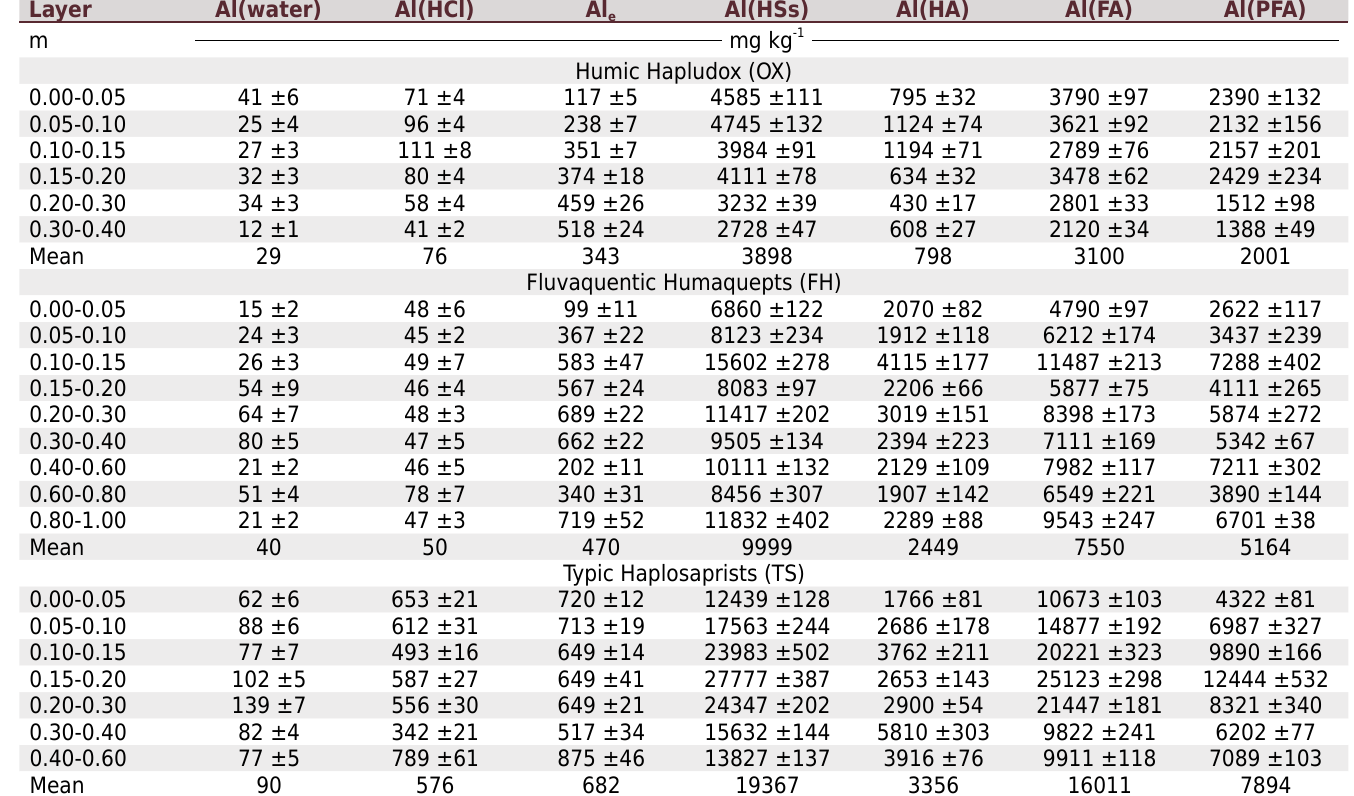
Table 5. Aluminum in water extract [Al (water) ], Al in HCl extract [Al (HCl) ], exchangeable Al 3+ (Al e ), Al in NaOH extract [Al (HSs) ], Al associated with HA [Al (HA) ], Al in FA extract [Al (FA) ], and Al in FA extract after purification with DAX-8 resin [Al (PFA) ] contents of soils in a toposequence under Araucaria moist forest in southern